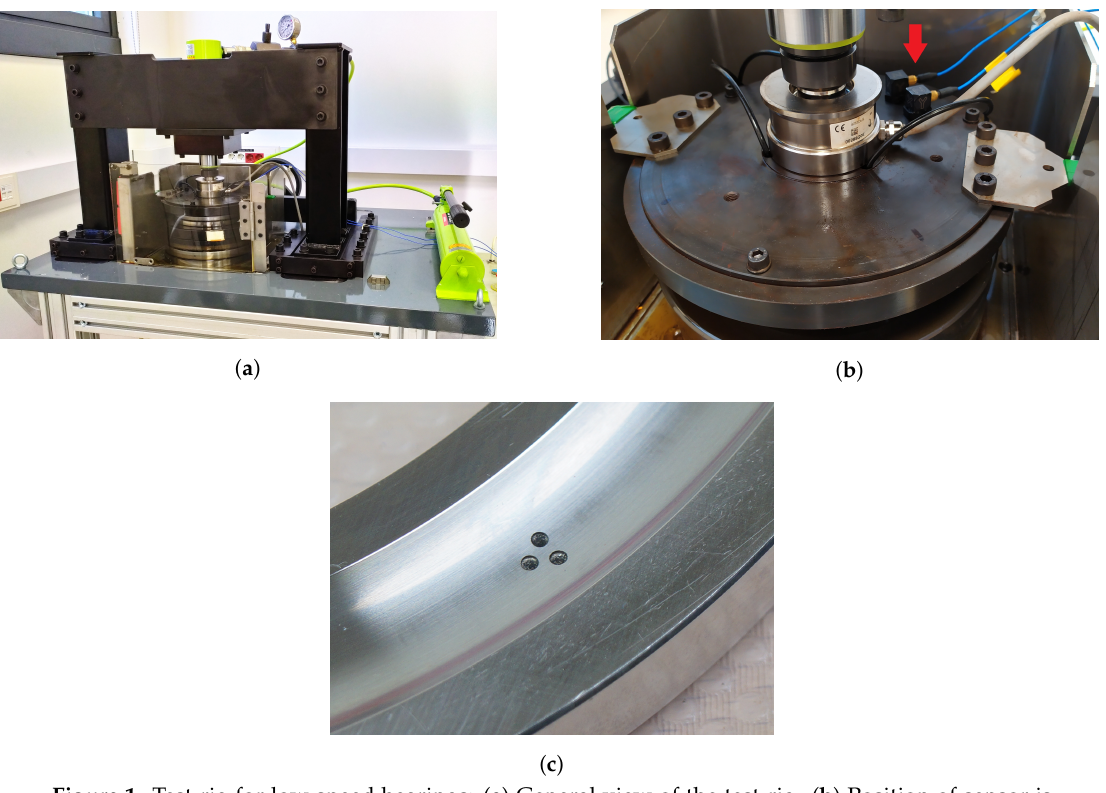
Figure 1. Test-rig for low speed bearings: ( a ) General view of the test-rig. ( b ) Position of sensor is highlighted with the red arrow. ( c ) Damage